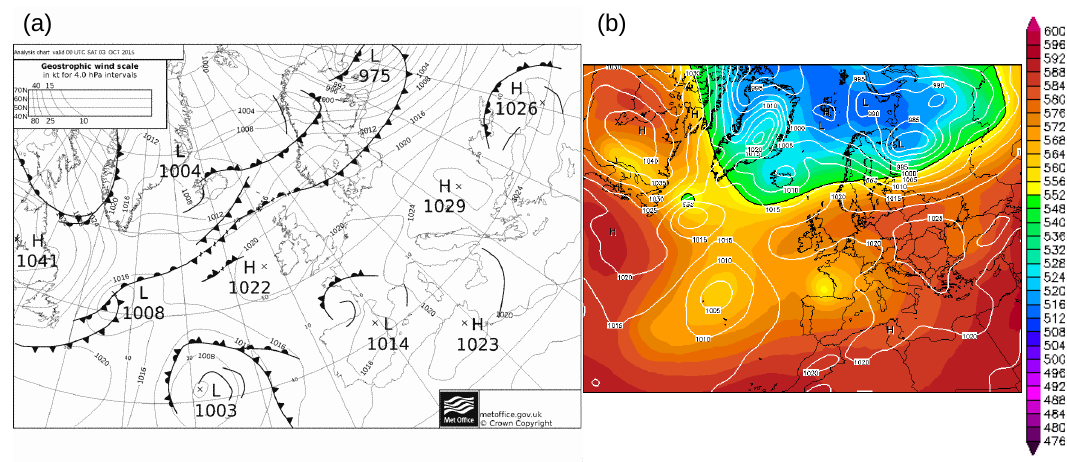
Figure 1. Synoptic situation over Europe at 00 UTC, 3 October 2015. Panel ( a ): UK Met Office analysis (from http://www.wetterzentrale.de/). Panel ( b ): 500 hPa geopotential height (geopotential decameter-gpdm , shaded contours) and mean sea level pressure (hPa, white contours) at 00 UTC, 3 October 2015. CFSR reanalysis from